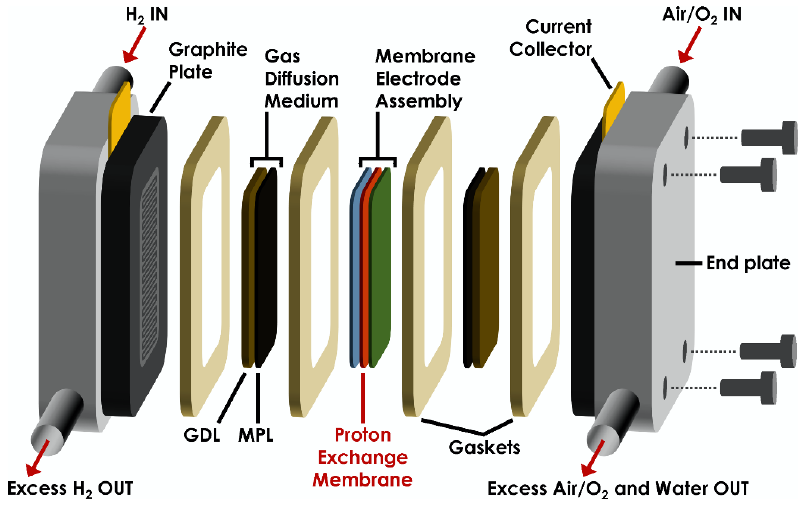
Figure 1. Structure of a polymer electrolyte membrane fuel cell (PEMFC).